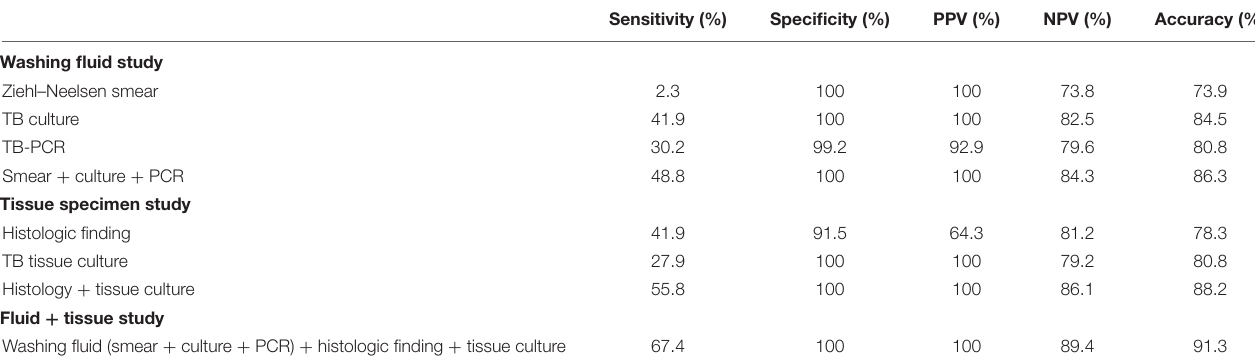
TABLE 3 | Performance of diagnostic modalities for TB infection in isolation and in